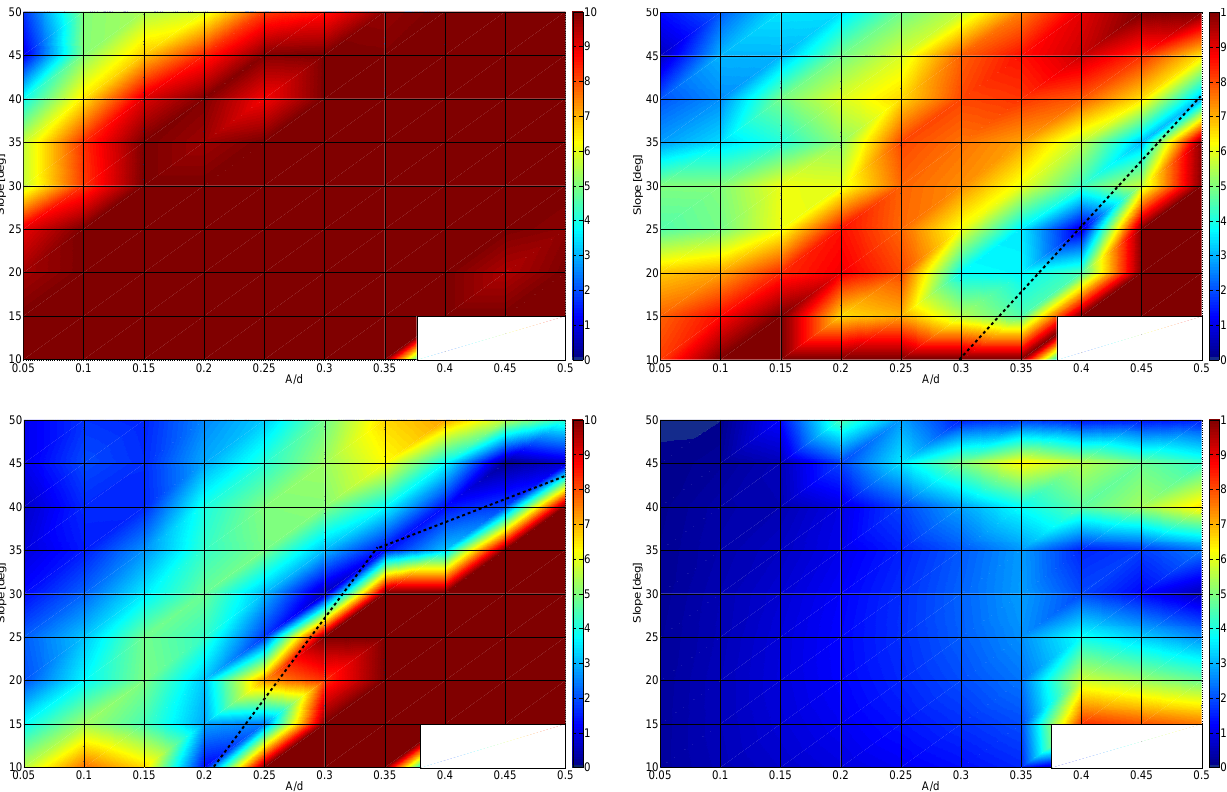
Fig. 5. Upper panels and lower left panel, accuracy of the R/A ratio for model 1a compared to reference model 2d as a function of the slope and initial amplitude (upper left, n = 100, upper right n = 200, and lower left n = 400 points per wavelength respectively). A Courant number of 0.1 is employed. Lower right, relative error of the R/A ratio for reference models 2a, 2b, and 2d. The color bar gives the accuracy in %. The white color indicates that maximum run-up is not reached in the reference models. The dashed lines indicate that instability is reached before maximum run-up is reached, typically beyond a given initial amplitude or below a given